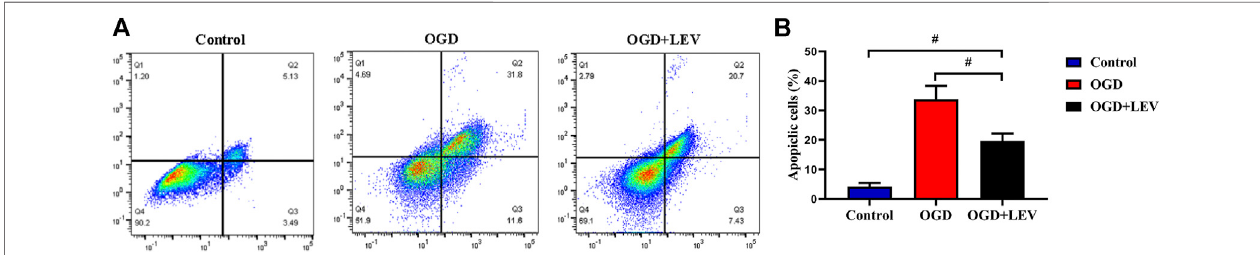
FIGURE 8 | Quantitative analysis of neuronal cell apoptosis by fl ow cytometry. (A) The number of apoptotic cells in the oxygen-glucose deprivation (OGD) group was increased signi fi cantly compared to the control group, but levetiracetam (LEV) reduced the apoptosis induced by OGD. (B) Quanti fi cation of cell apoptosis in the different groups. # p < 0.01 compared to the saline and control